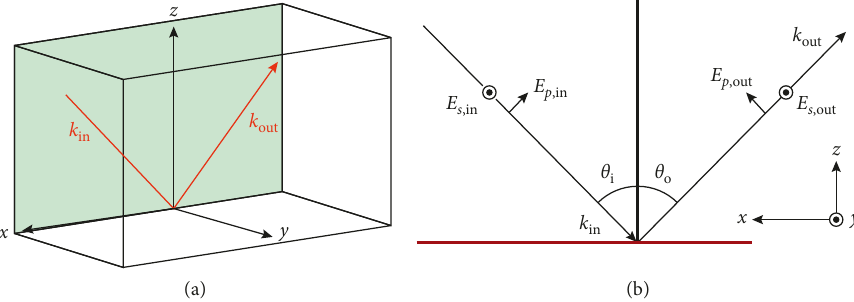
Figure 1: Coordinate system showing the incoming p -polarized field and the outgoing p - and s -polarized fields. It follows from the assumptions of SBHM that the response for the bond, which is almost parallel to the incoming field, is